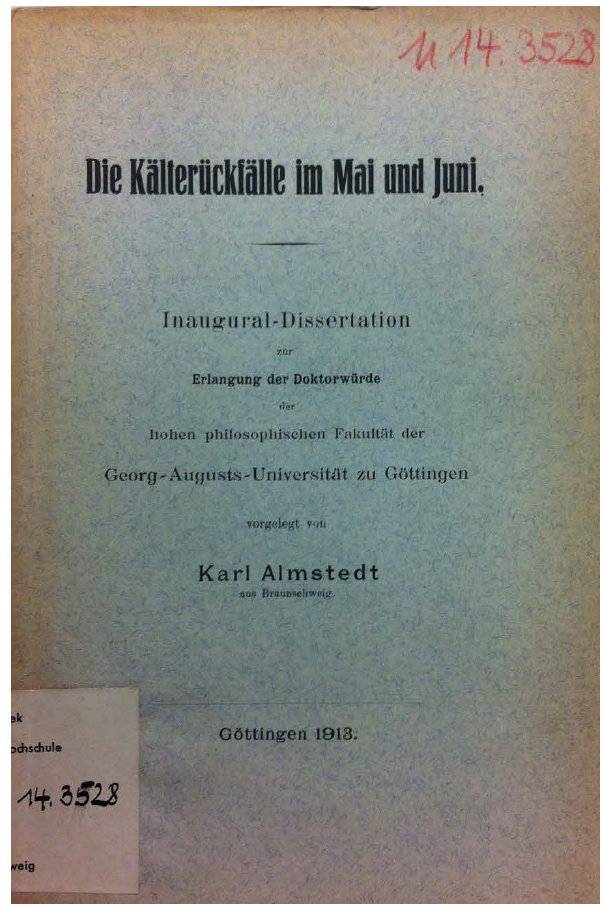
Figure 2. Title page of the dissertation of Karl Friedrich Almst- edt, reproduced with the permission of the Universitätsbibliothek Braunschweig.